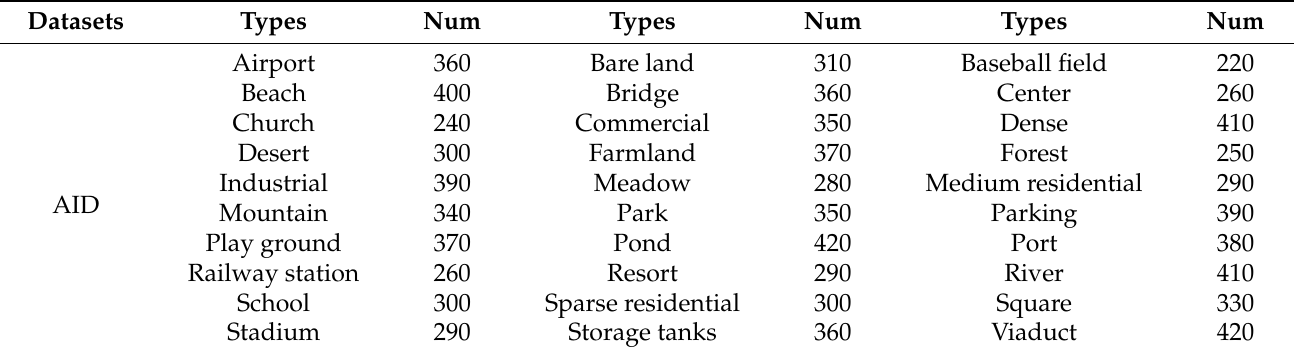
Table 2. Different semantic categories and corresponding number of images in each type of AID dataset. Datasets